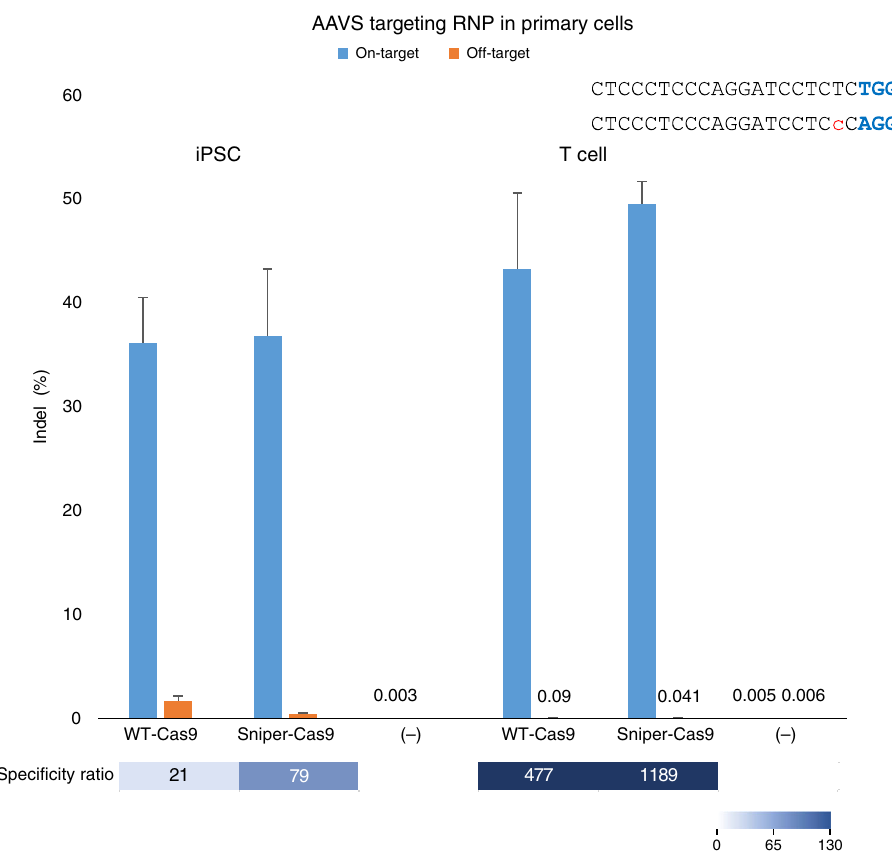
Fig. 6 On-target and off-target activities of WT-Cas9 or Sniper-Cas9 paired with a gX19 guide RNA targeting AAVS and delivered via RNP into iPS cells and T cells. Speci fi city ratios were determined by dividing the on-target activity by the off-target activity. ( − ) indicates the absence of RNP. Error bars